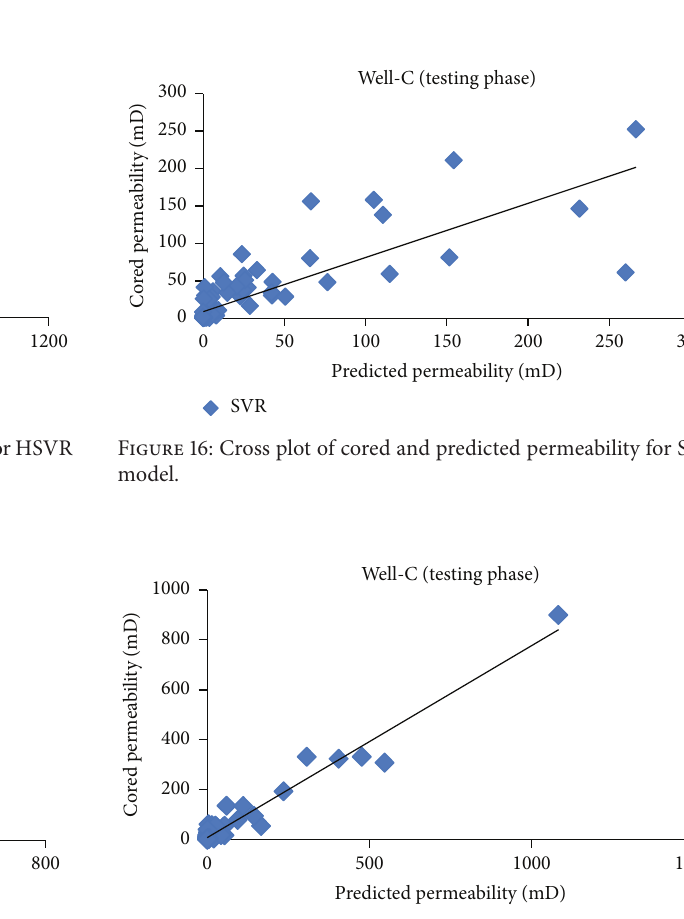
Figure 12: Cross plot of cored and predicted permeability for SVR model.